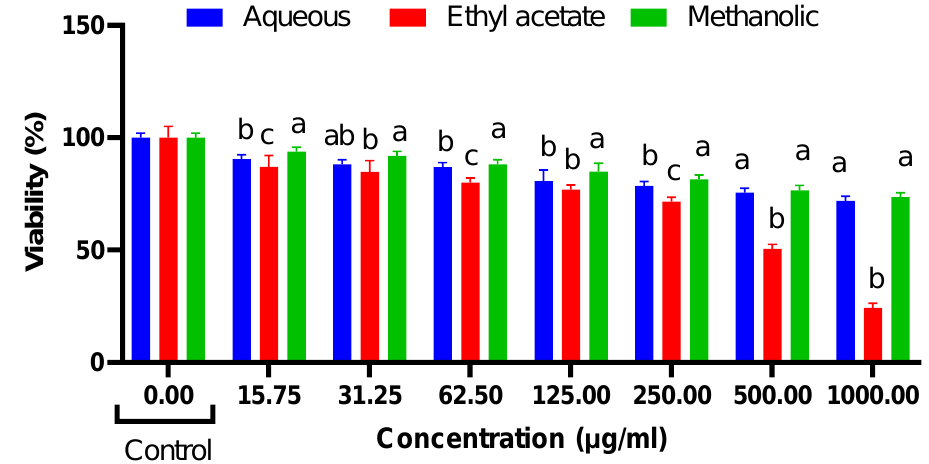
Figure 2. Cell cytotoxicity on NIH 3T3 cells (one-way ANOVA, different letters indicate significant difference between extracts in the same concentration (a, b and c), p ≤ 0.05.).